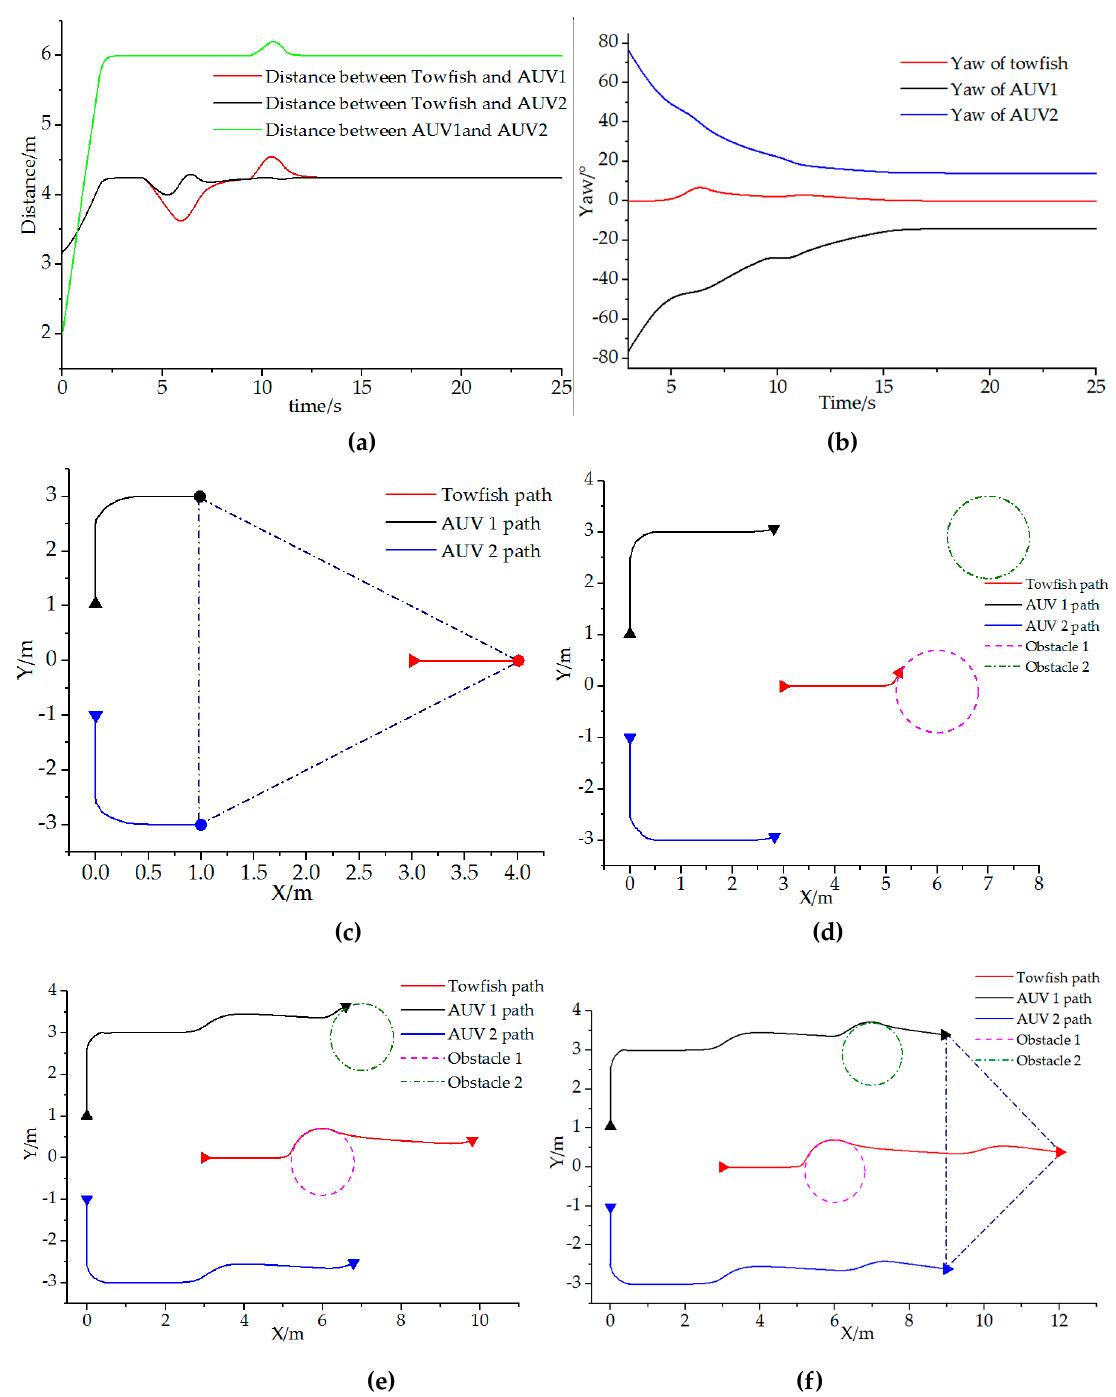
Figure 12. Vehicle formation paths with obstacle avoidance.